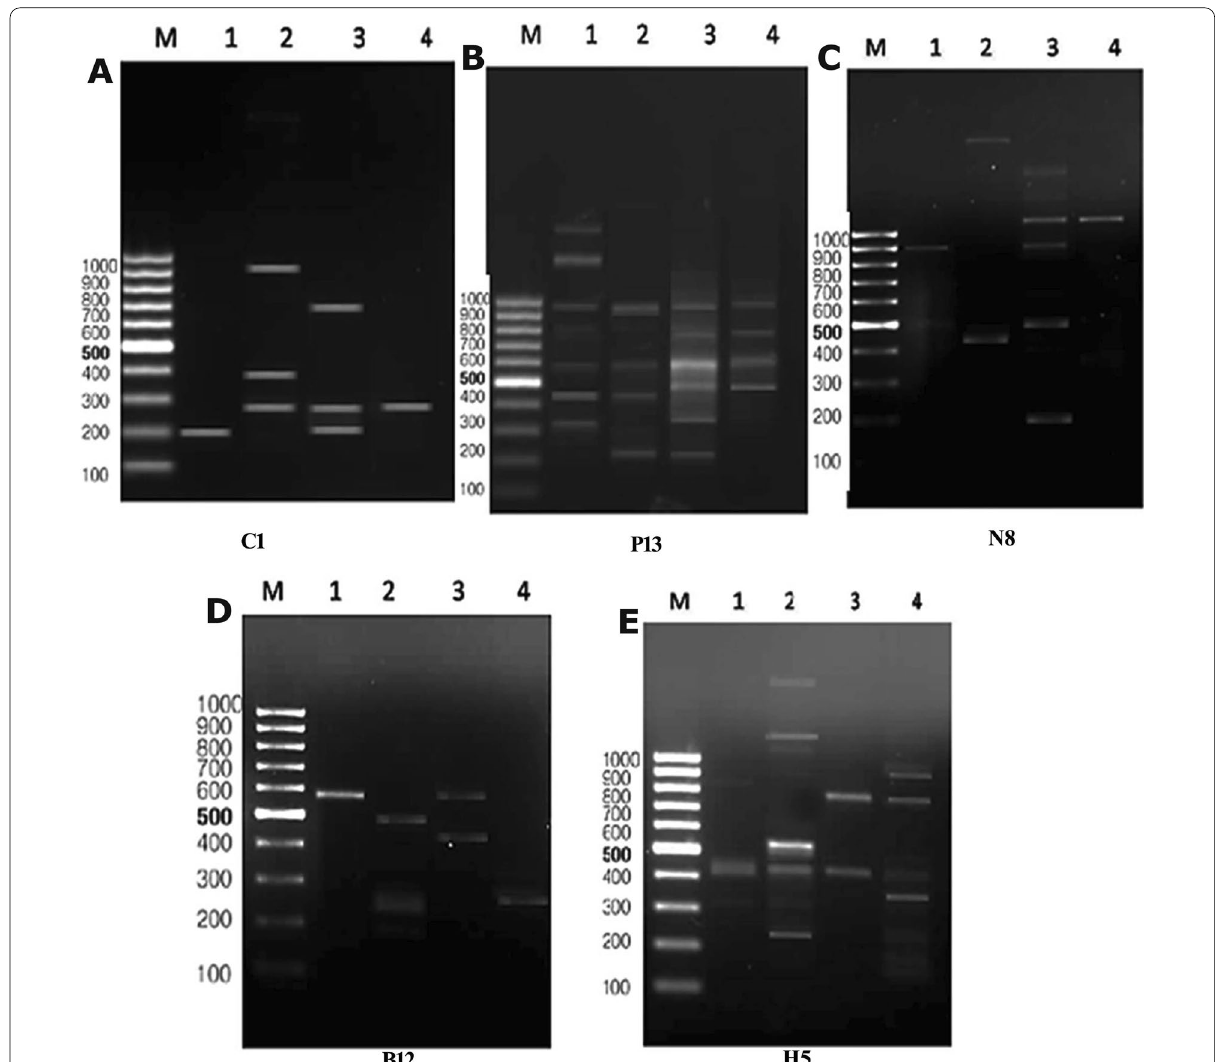
Fig. 2 Random amplified polymorphic DNA profiles of genomic DNA from Eobania vermiculata under different duration of chitosan exposure using five primers. a Profile generated by primer C1, b profile generated by primer P13, c profile generated by primer N8, d profile generated by primer